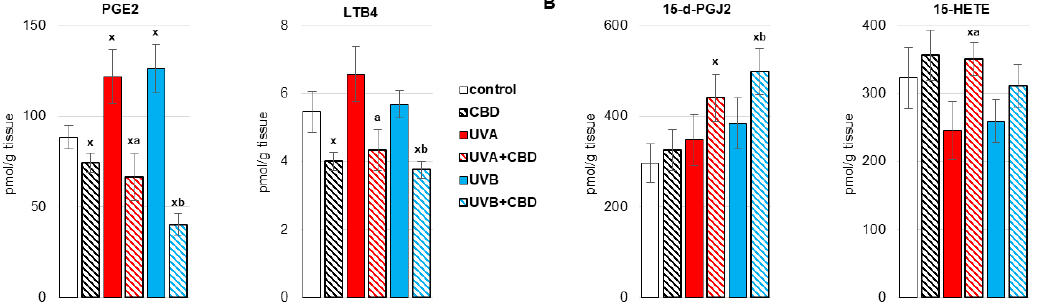
Figure 5. The activity of enzymes involved in the metabolism of eicosanoids (phospholipases A2 (PLA2), cyclooxygenase 1 (COX1), cyclooxygenase 2 (COX2)) in the liver of nude rats in the following groups: treated with CBD (every 12 h) for 4 weeks; irradiated with UVA (every 48 h) and treated with CBD (every 12 h) for 4 weeks; irradiated with UVB (every 48 h) and treated with CBD (every 12 h) for 4 weeks. The mean values for six rats in each group ± SD are shown: x—differences vs. control group, p < 0.05; a—differences vs. UVA treated group, p < 0.05; b—differences vs. UVB treated group, p < 0.05.